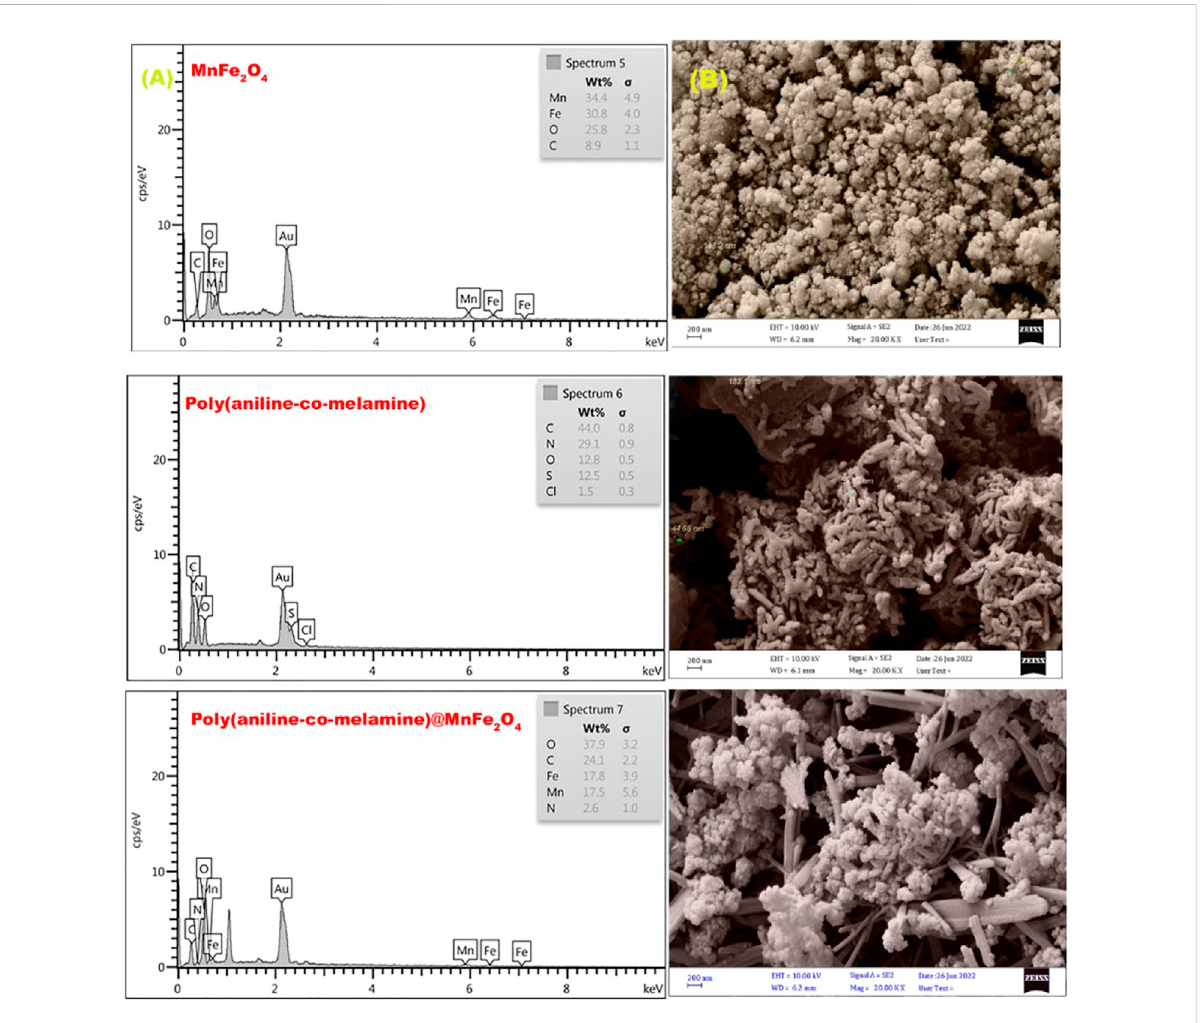
Figure 5. The VSM curves show that the magnetization saturation values of MnFe 2 O 4 nanoparticles and poly(aniline- co -melamine)@MnFe 2 O 4 were